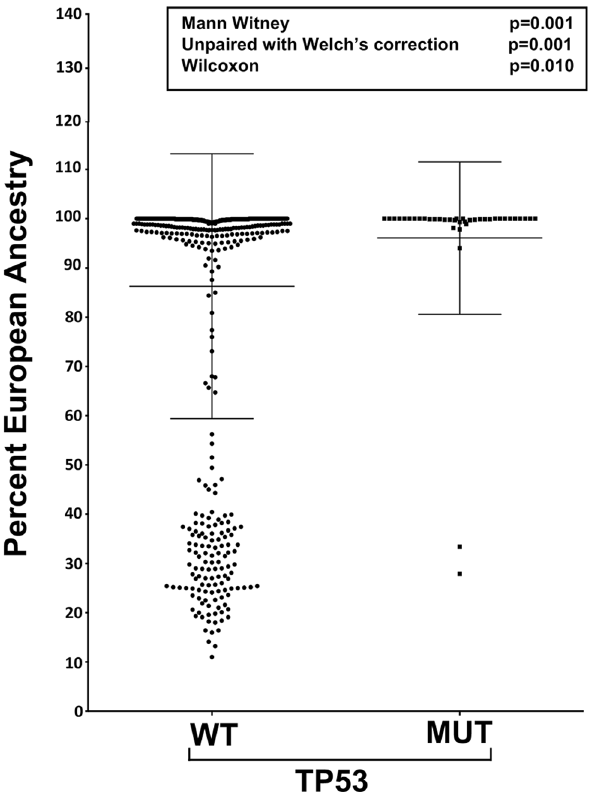
Fig 4. Alteration of TP-53 across ancestry. Analysis of TP53 state across the percent Europeanancestry. Each dot represents individual sample. To validatestatistical power, we performed Mann-Witney, Wilcoxon, and Unpaired t-test with Welch’s correction with statistical significanceset at p < 0.05.